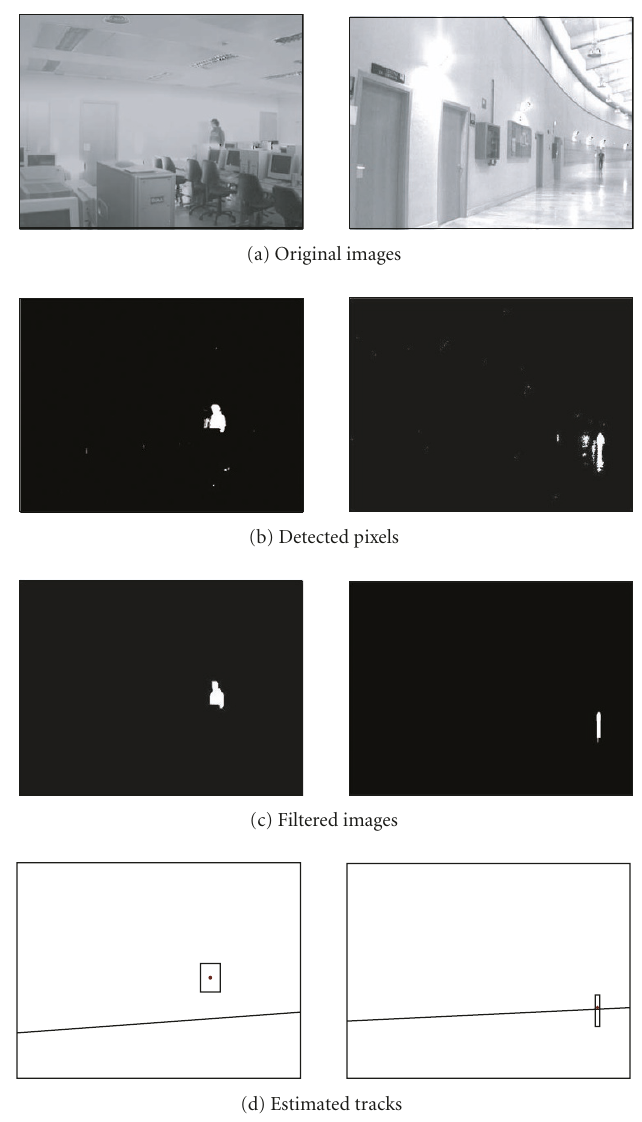
Figure 4: Information levels in the processing chain. Characters from (a) to (d) are related to the modules of Figure 3.